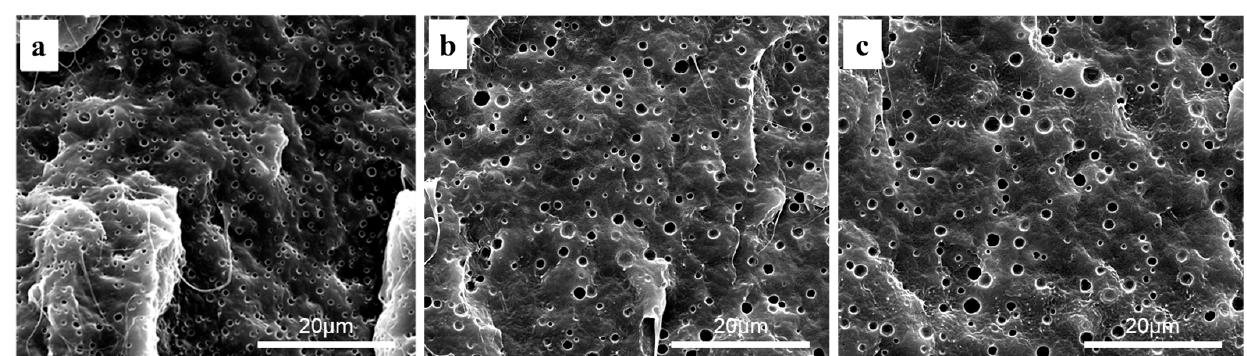
Figure A1. PCL/MPT after being immersed in PBS: ( a ) MPT5-100, ( b ) MPT10-100, ( c ) MPT20-100.